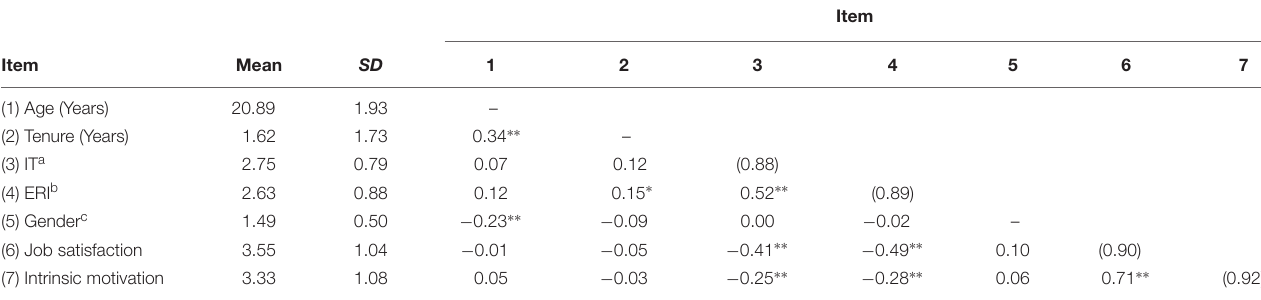
TABLE 1 | Means, standard deviations, and correlations of study variables.